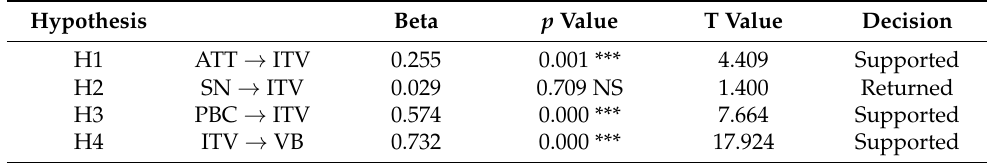
Table 2. Hypotheses in the structural model.